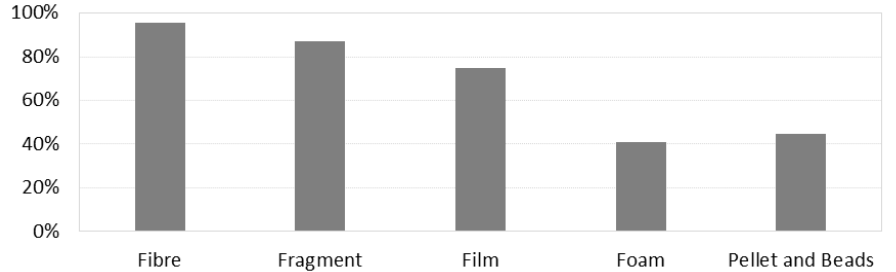
Figure 9. Shape of MP identified in studies .